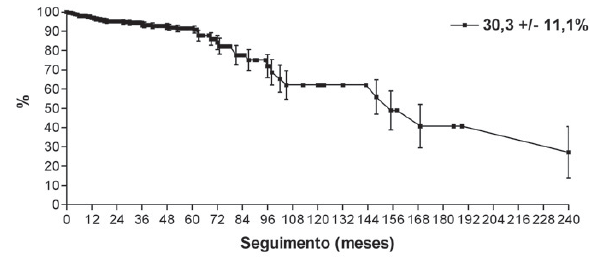
Fig. 3 - Curva atuarial livre de reoperação